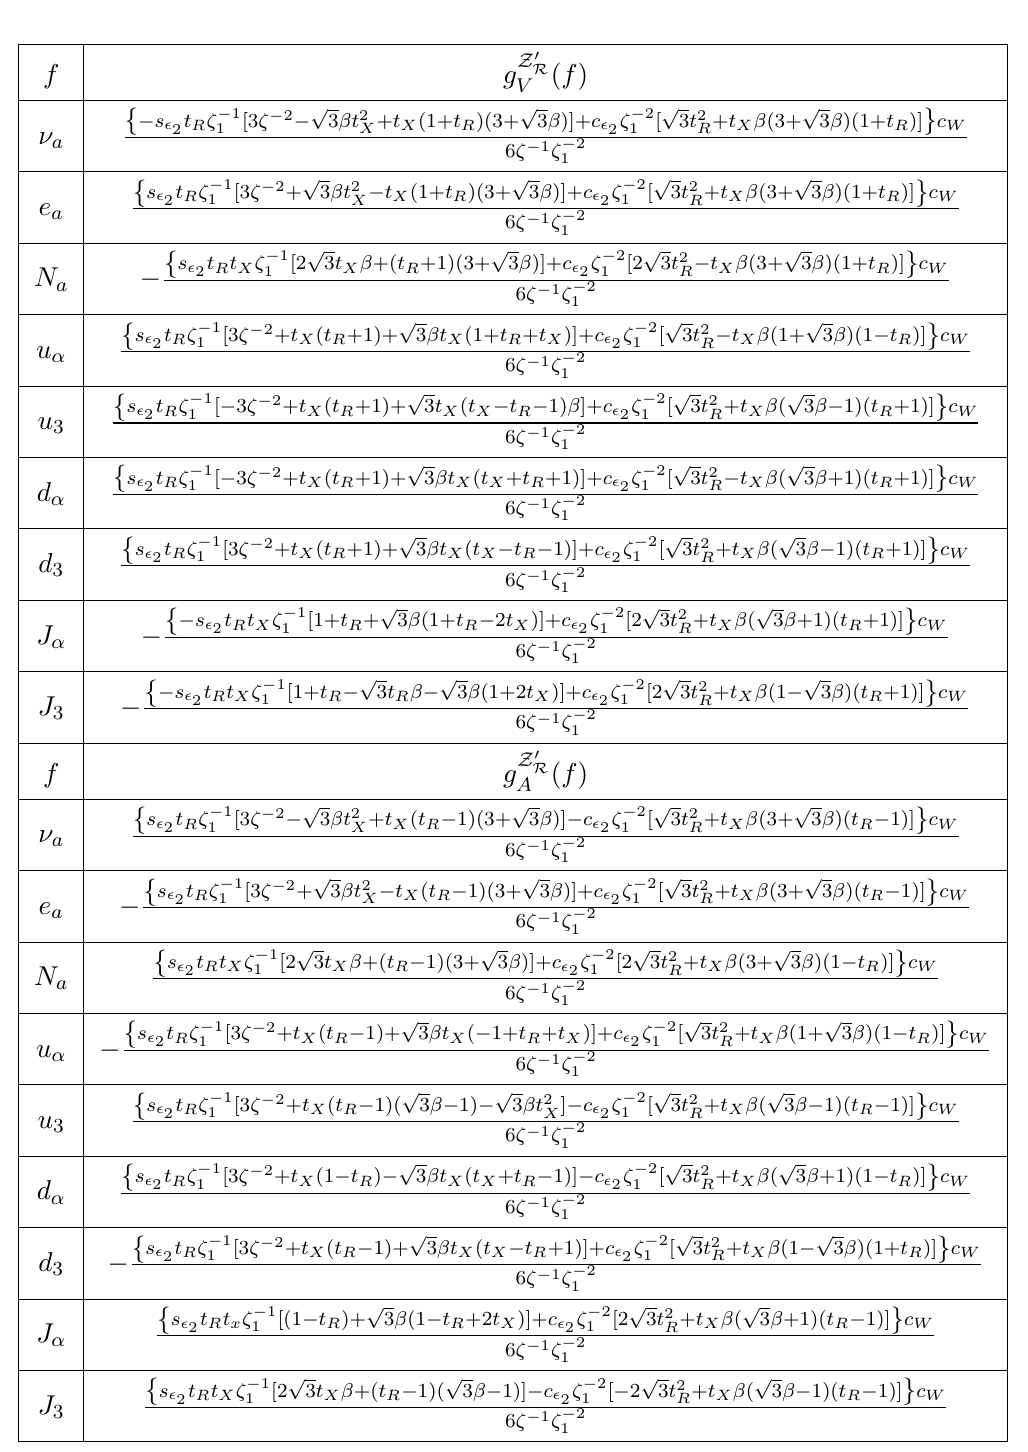
Table 5 . The couplings of Z 0